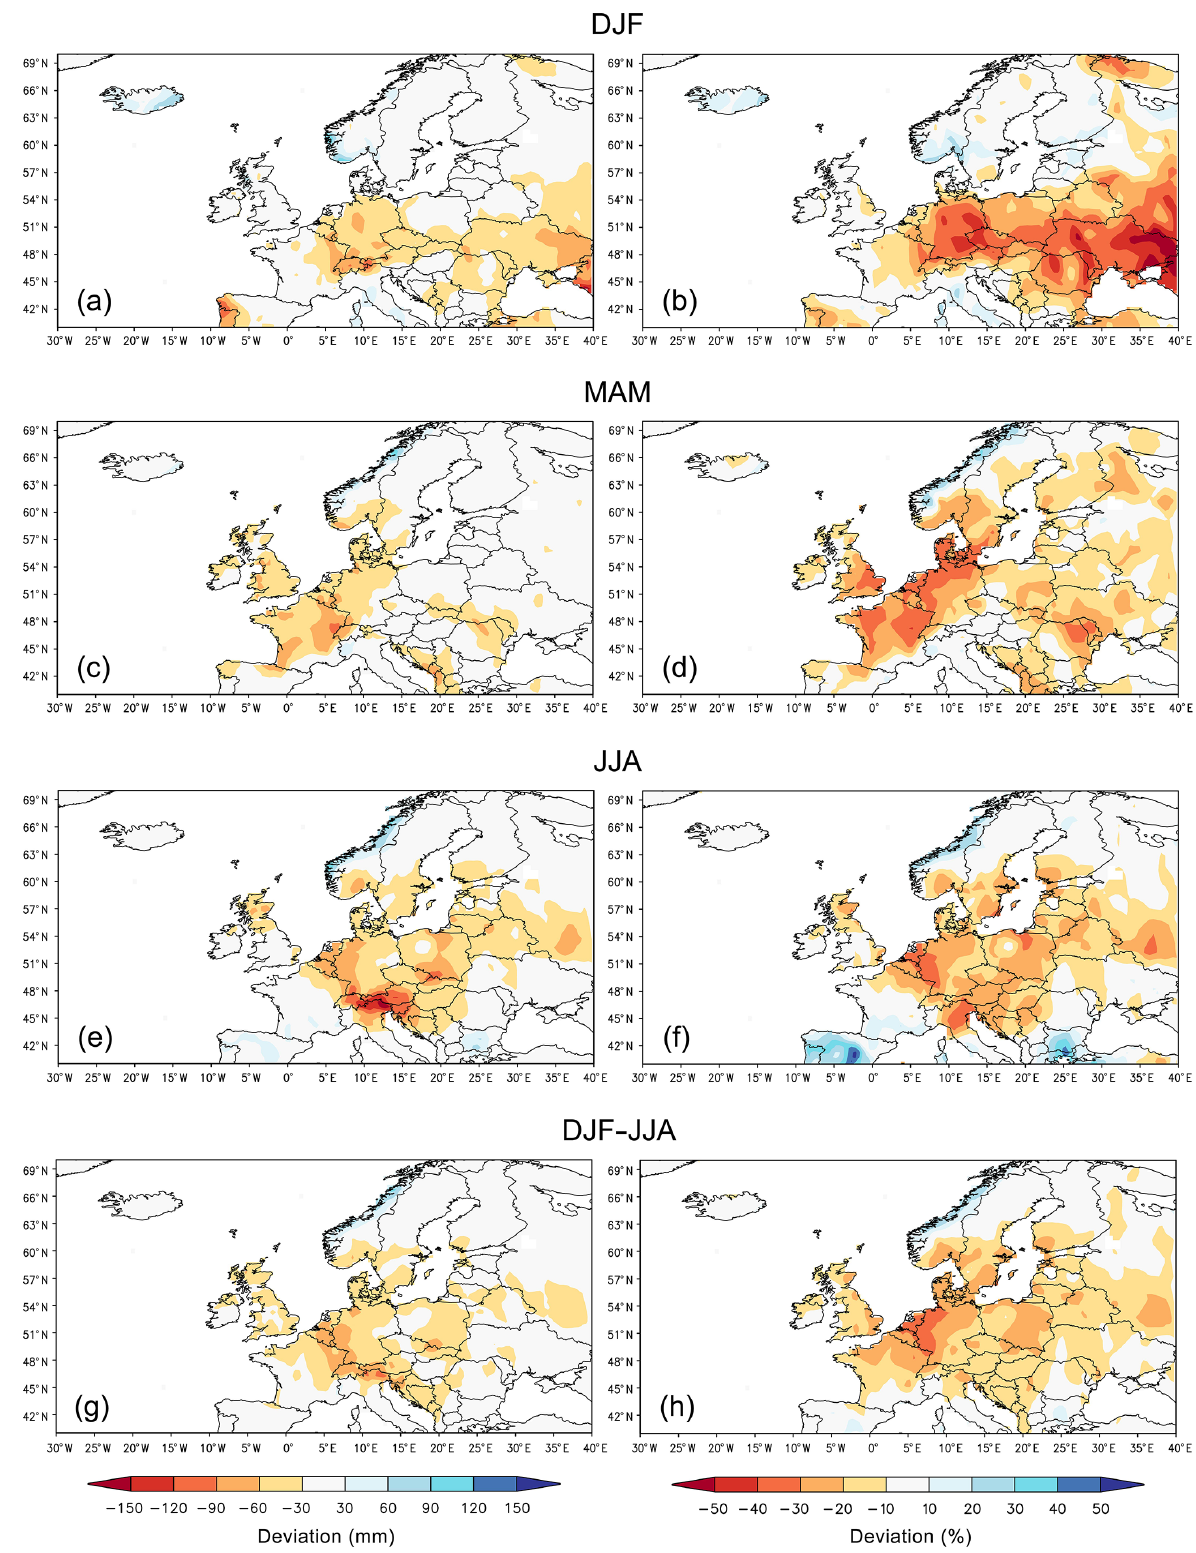
Figure 3. Precipitation patterns of DJF (a) , MAM (c) , JJA (e) , and DJF–JJA (g) and their expression as percentages of the corresponding parts of the seasonal means in the 1961–1990 reference period (b, d, f, h) over the European lands (data from Pauling et al.,